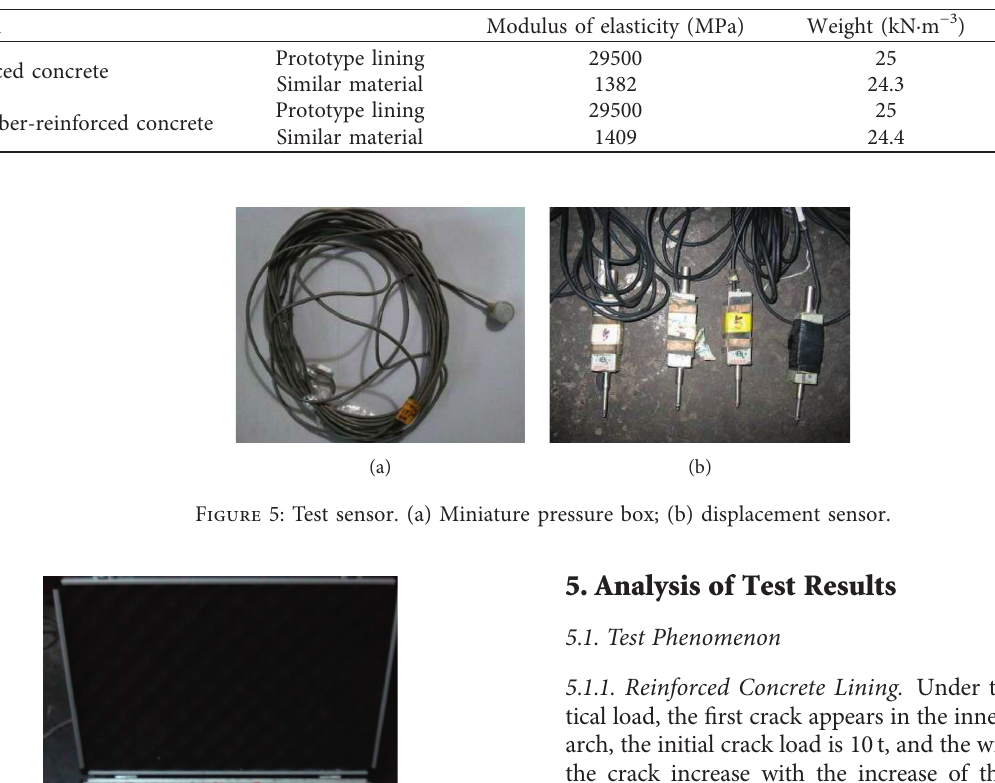
Table 7: Physicomechanical parameters of lining.